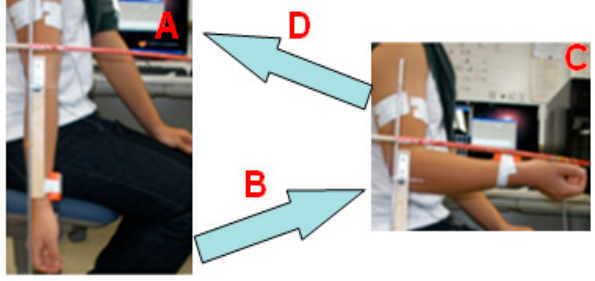
Figure 1. Four motion patterns to be recognized.